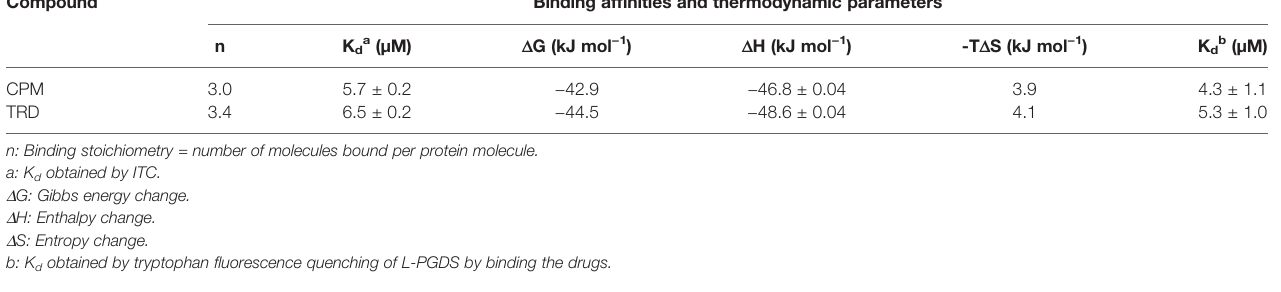
TABLE 3 | Binding af fi nities and thermodynamic parameters for interaction between L-PGDS with CPM and TRD. Compound Binding af fi nities and thermodynamic